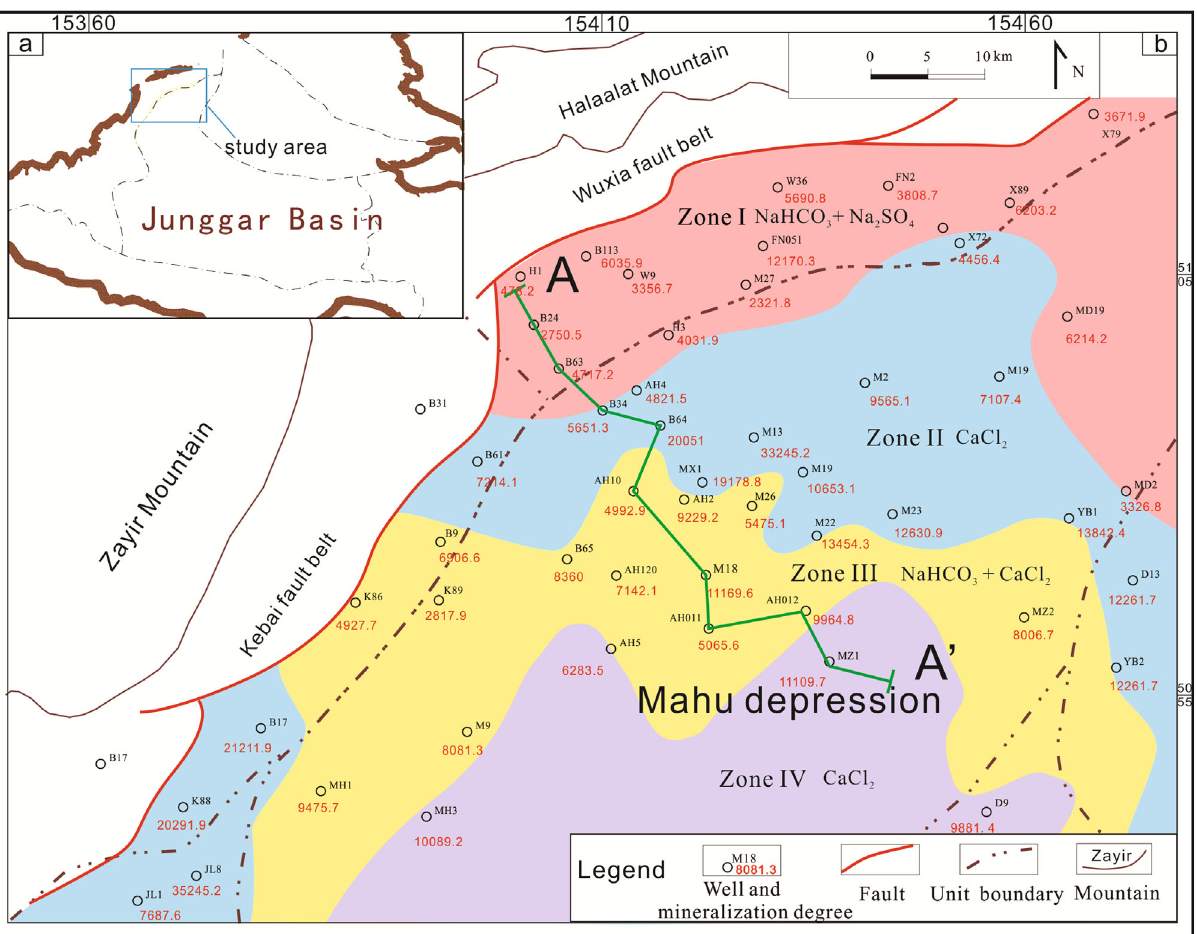
Figure 1: (a) Location of the study area. (b) Geological setting of the Mahu depression with zones for di ff erent oil fi eld water types.